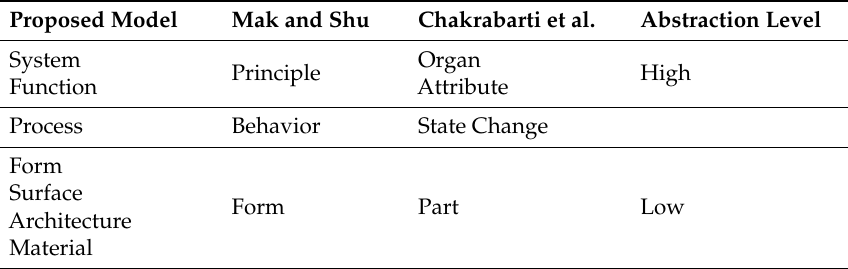
Table 2. Analogy Categories Compared to Supporting Work.